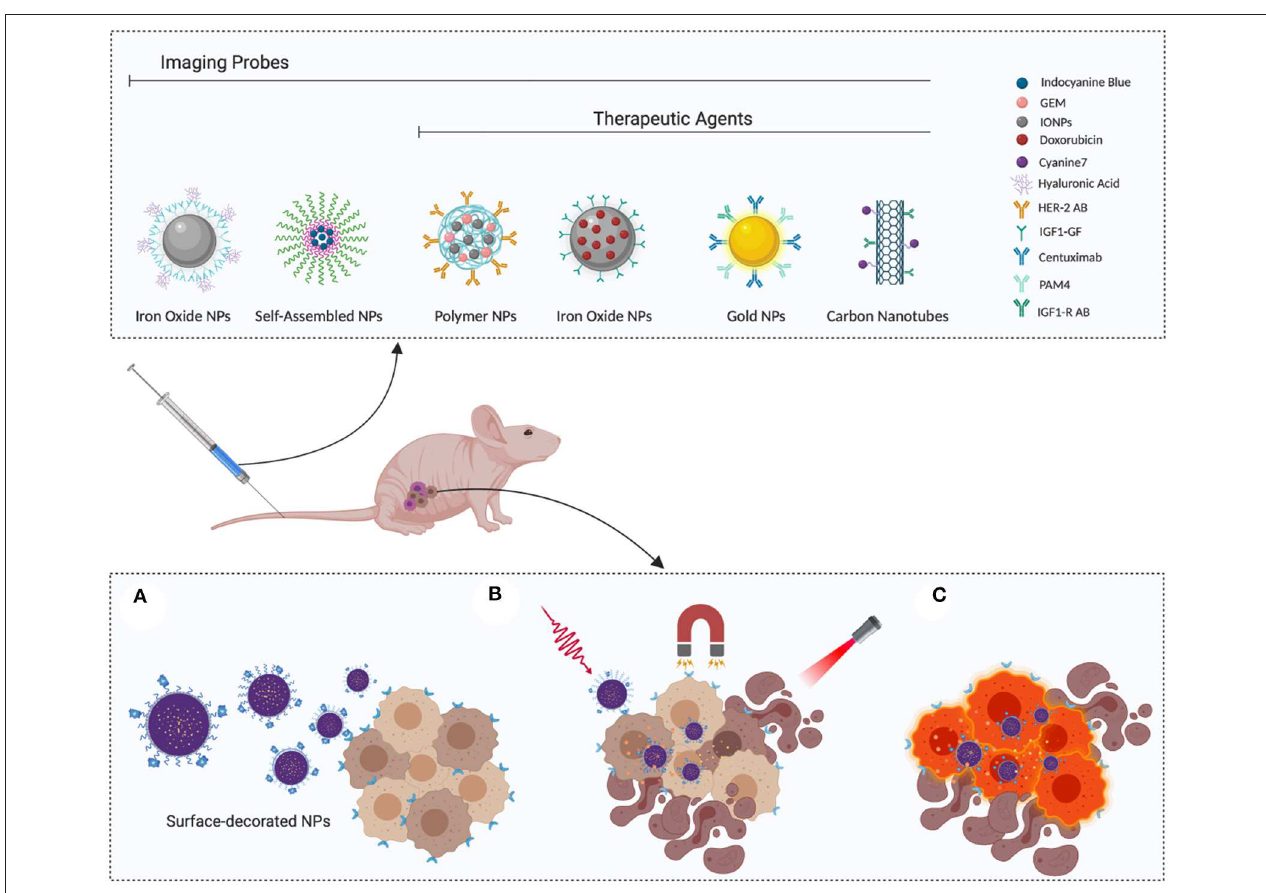
FIGURE 1 | Smart nanoparticles for PDAC theranostic: (A) Surface-functionalized nanoparticles actively recognize tumor cells, thereby enhancing selective accumulation. (B) Once they reach the target site, release can be triggered by applying external stimuli, such as magnetic field or irradiation. (C) Selective recognition of cancer cells can be exploited to enhance their visualization, favoring complete eradication during surgery or disease monitoring with classic diagnostic tools, such as PET or MRI. Image created with